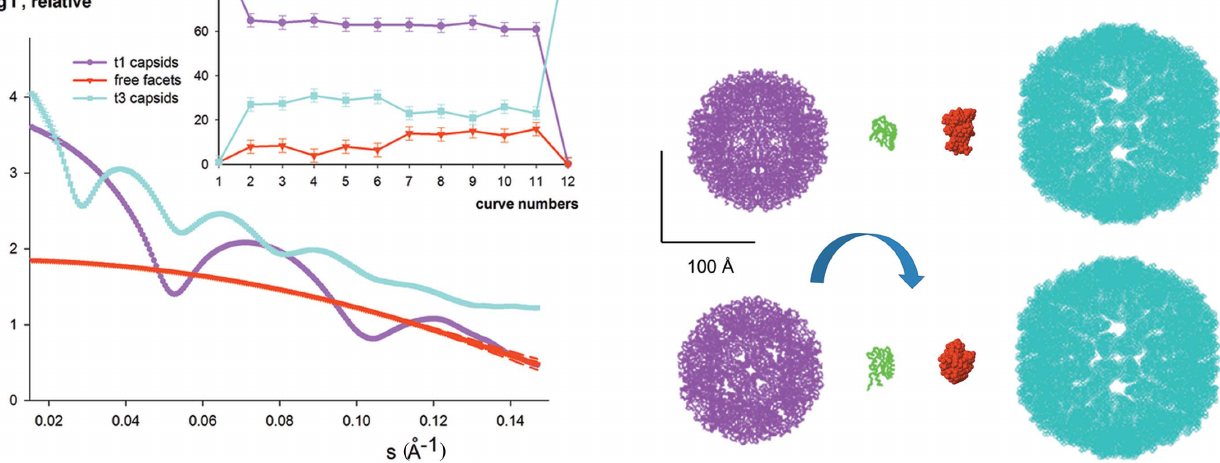
Figure 3 Intermediate detection in lumazine synthase capsid formation. The top left panel displays the data measured at different conditions [curve 1, wild type lumazine synthase from B. subtilis (LSBS) in borate buffer (pH 7.0); curves 2–6, wild type lumazine synthase from A. aeolicus (LSAQ) in phosphate buffer (pH 6.0, 6.5, 7.0, 7.5, 8.0); curves 7–11, LSAQ in Tris buffer (pH 7.0, 7.5, 8.0, 8.5, 9.0); curve 12, LSAQ mutant in Tris buffer (pH 8.0)]. The experimental data are shown as dots with error bars and the DAMMIX fits as red solid lines. Known ‘initial’ and ‘final’ states, t1 capsids of diameter 160 A ˚ and t3 capsids of diameter of 300 A ˚ , respectively, are shown in the bottom right panel with magenta and cyan beads. The experimental data from LSBS in borate buffer and LSAQ mutant in Tris buffer (curves 1 and 12, respectively) corresponding to these models were used as input in DAMMIX after regularization by GNOM (Svergun, 1992). The monomeric lumazine synthase (PDB entry 1rvv) is shown with green C (cid:3) traces, and a typical restored shape of the unknown component (dissociated fragments of capsids) obtained by DAMMIX is displayed with red beads. The scale bar is 100 A˚ . The scattering curves from the components are shown in the bottom left panel (the two most different restored curves for the intermediate obtained from multiple DAMMIX runs are shown with dashed red lines) and their restored volume fractions are displayed in the inset; the colours are the same as the bottom right panel and the error bars of volume fractions display the average dispersion over multiple DAMMIX